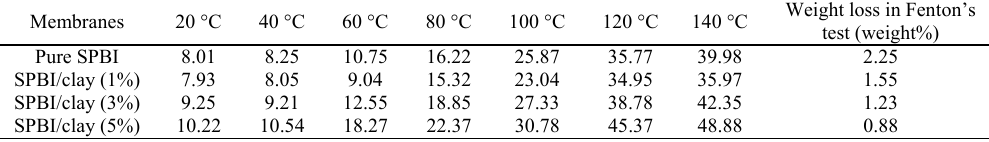
Table 4. Proton conductivity and weight loss (weight%) in Fenton’s test of the membranes with clay content.